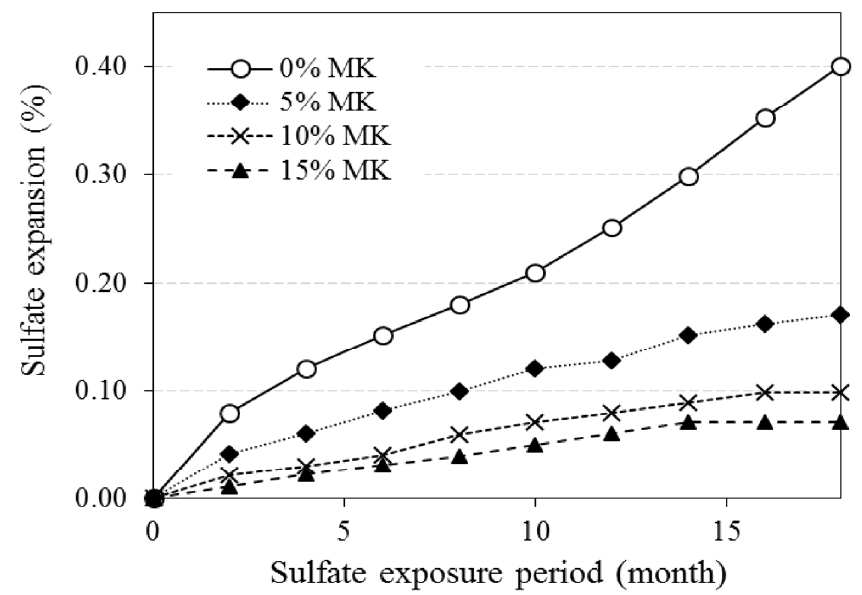
Figure 5. Effect of MK on sulfate expansion with time at a w/b ratio of 0.5.